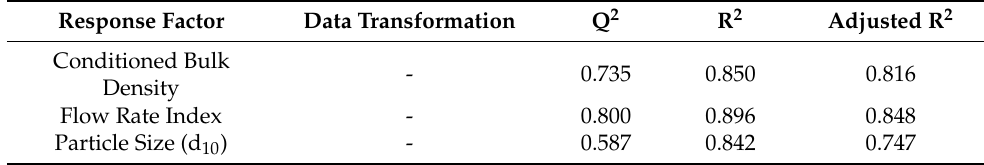
Figure 7. Coefficients plot of model terms regarding tablet press parameters. The 95% confidence interval is displayed as an error bar. F D [ mm ]